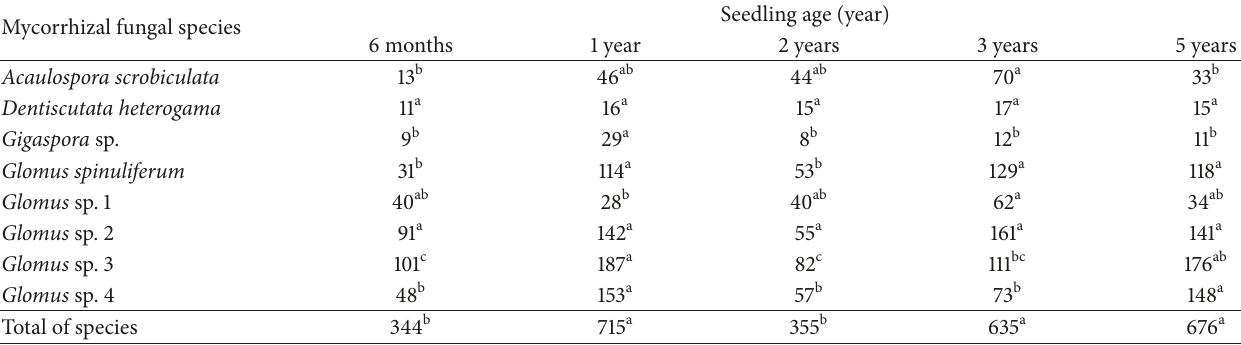
Table 2: Mean number of mycorrhizal spores of araucaria seedlings with ages between 6 months and 5 years grown in a nursery field in Curitiba,